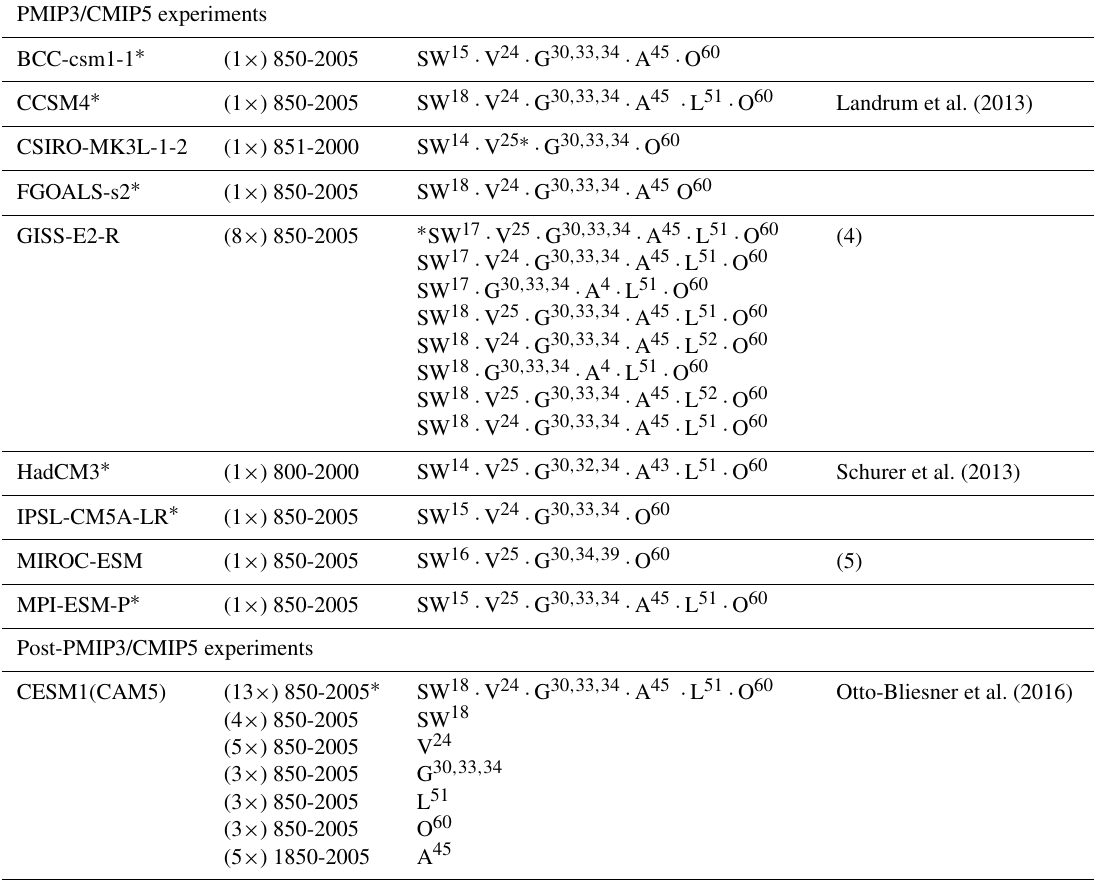
Table 1. PMIP3/CMIP5 and post-PMIP3/CMIP5 simulations of the CE and their associated forcings. PMIP3/CMIP5